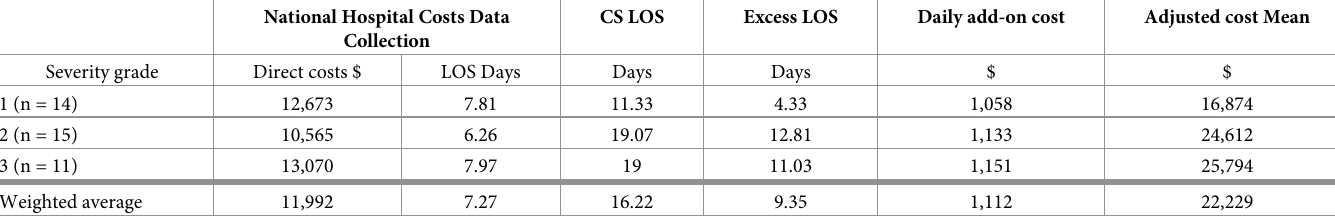
Table 5. Average hospital costs, length of stay and adjusted cost per episode, by severity grade.